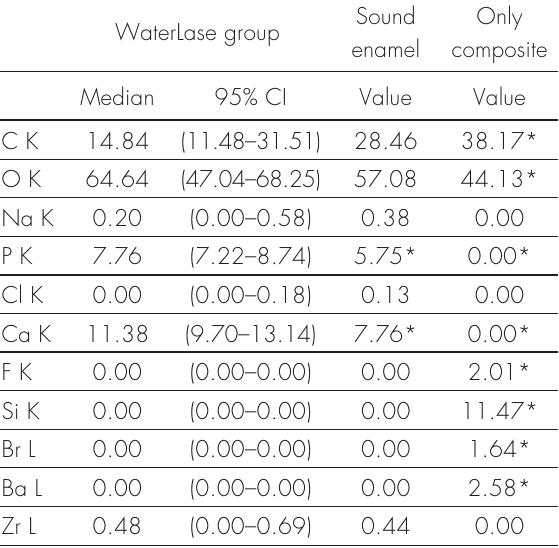
Table I. Comparison of atomic concentrations: medians and 95% confidence intervals in six WaterLase Biolase ® samples and individual values for control